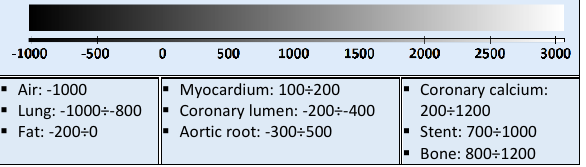
Figure 2: Hounsfield map grey scale representation and tissues densities, used visualization of CT